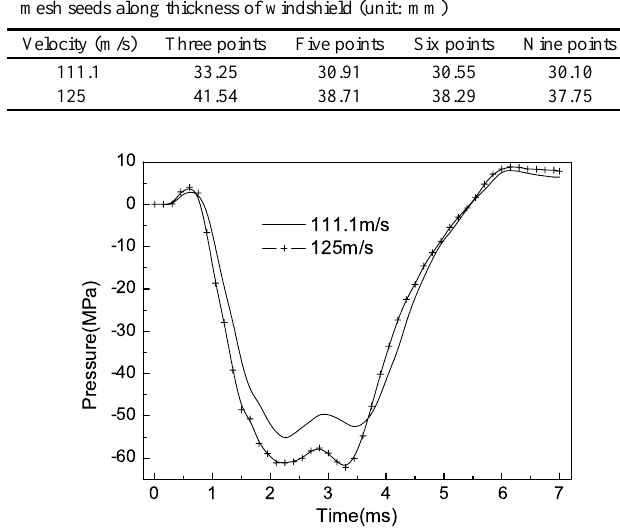
Fig. 10. Time history of pressure at the center on inner